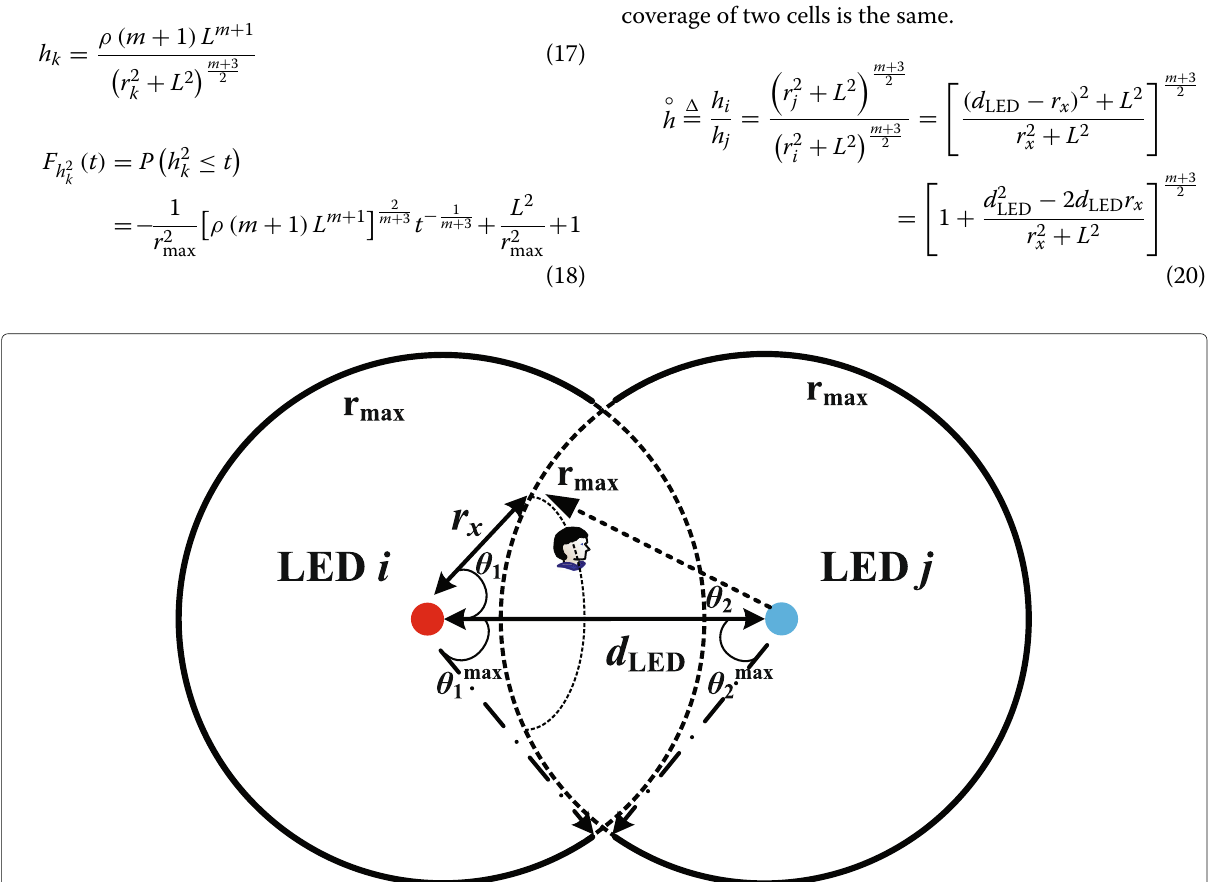
Fig. 3 Geometrical parameters of an edge user within the overlap